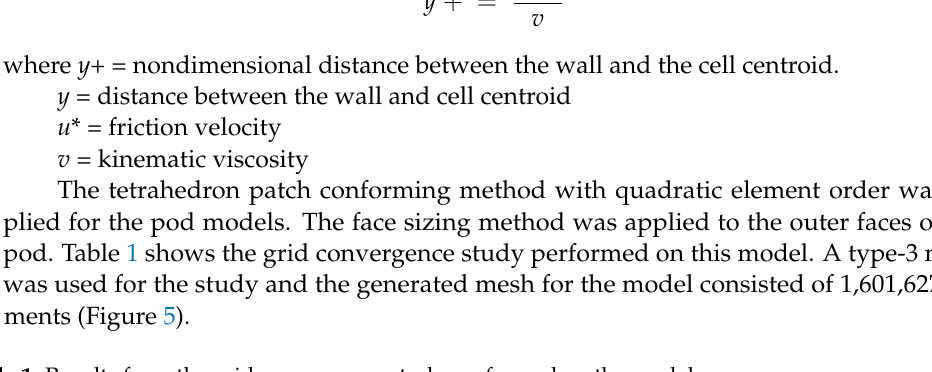
Table 1. Results from the grid convergence study performed on the model.